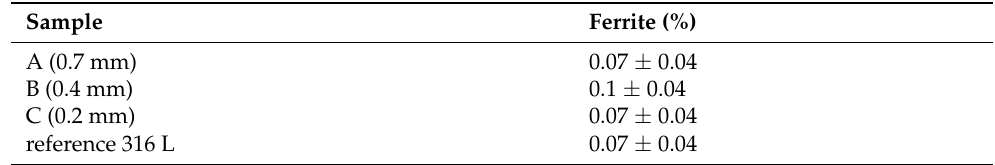
Table 3. Ferrite content in the samples measured by